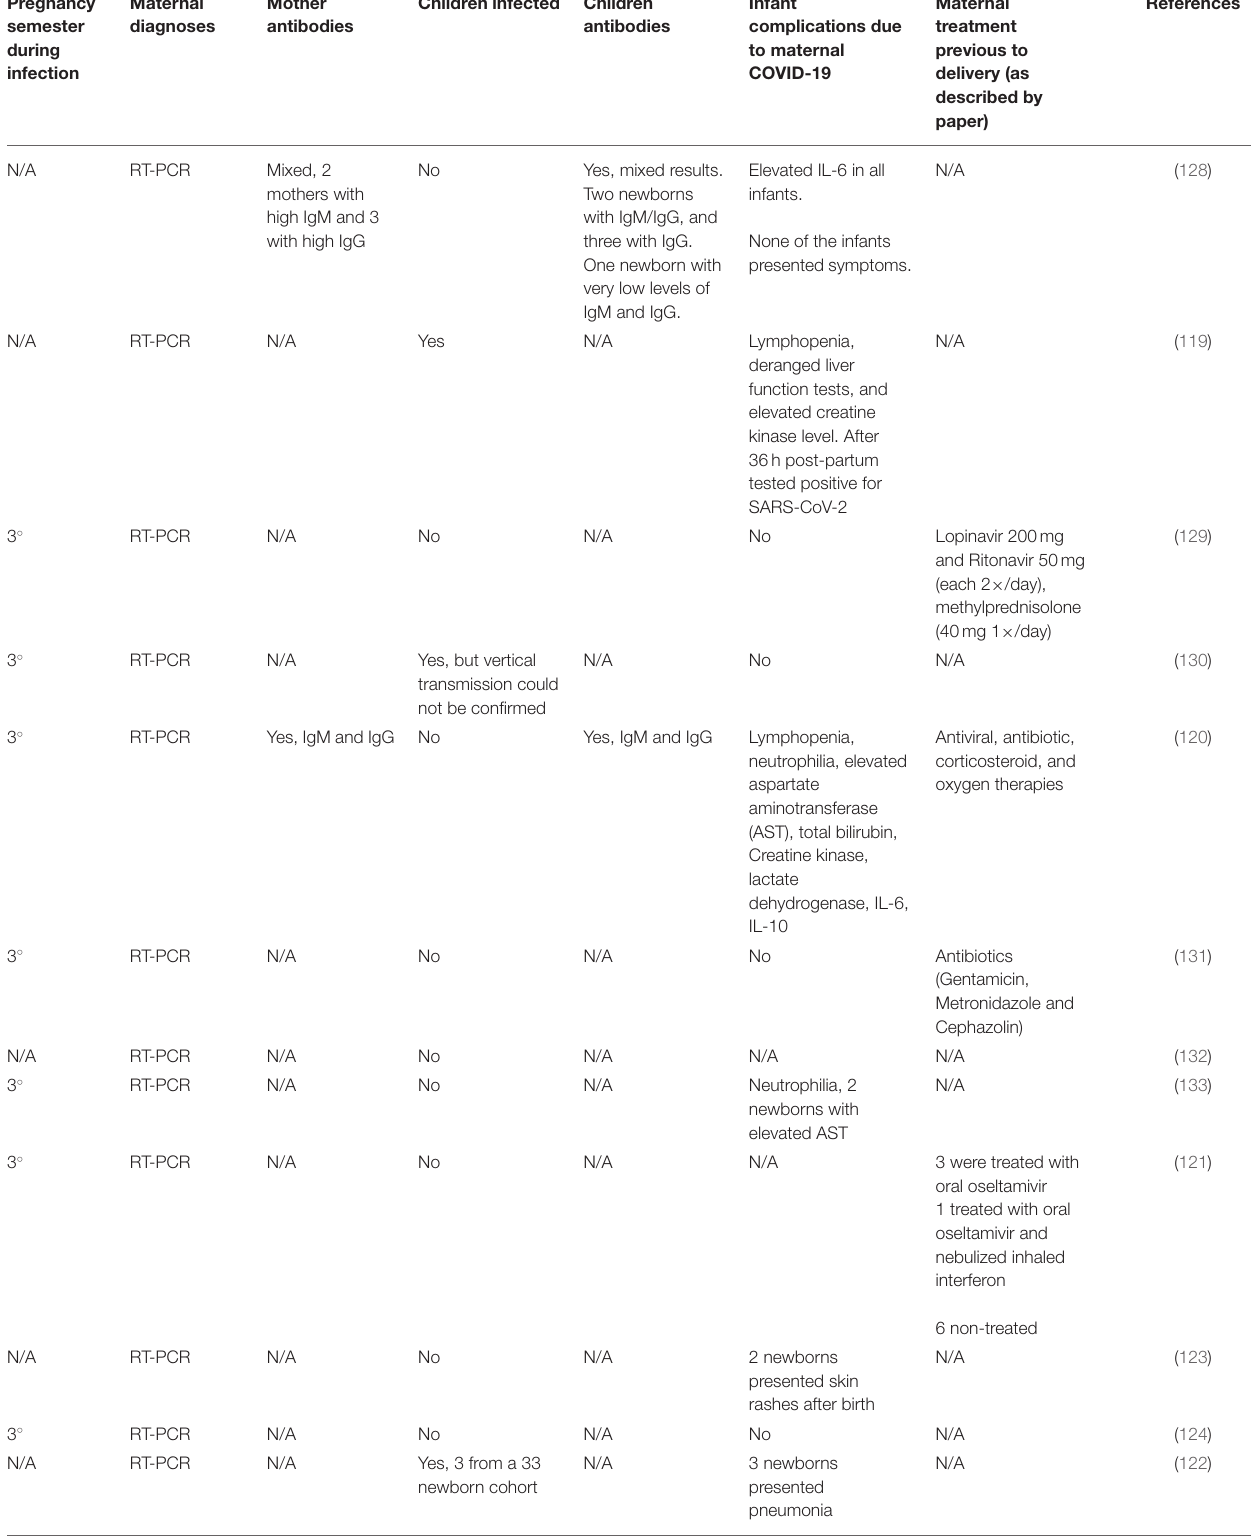
Maternal diagnoses